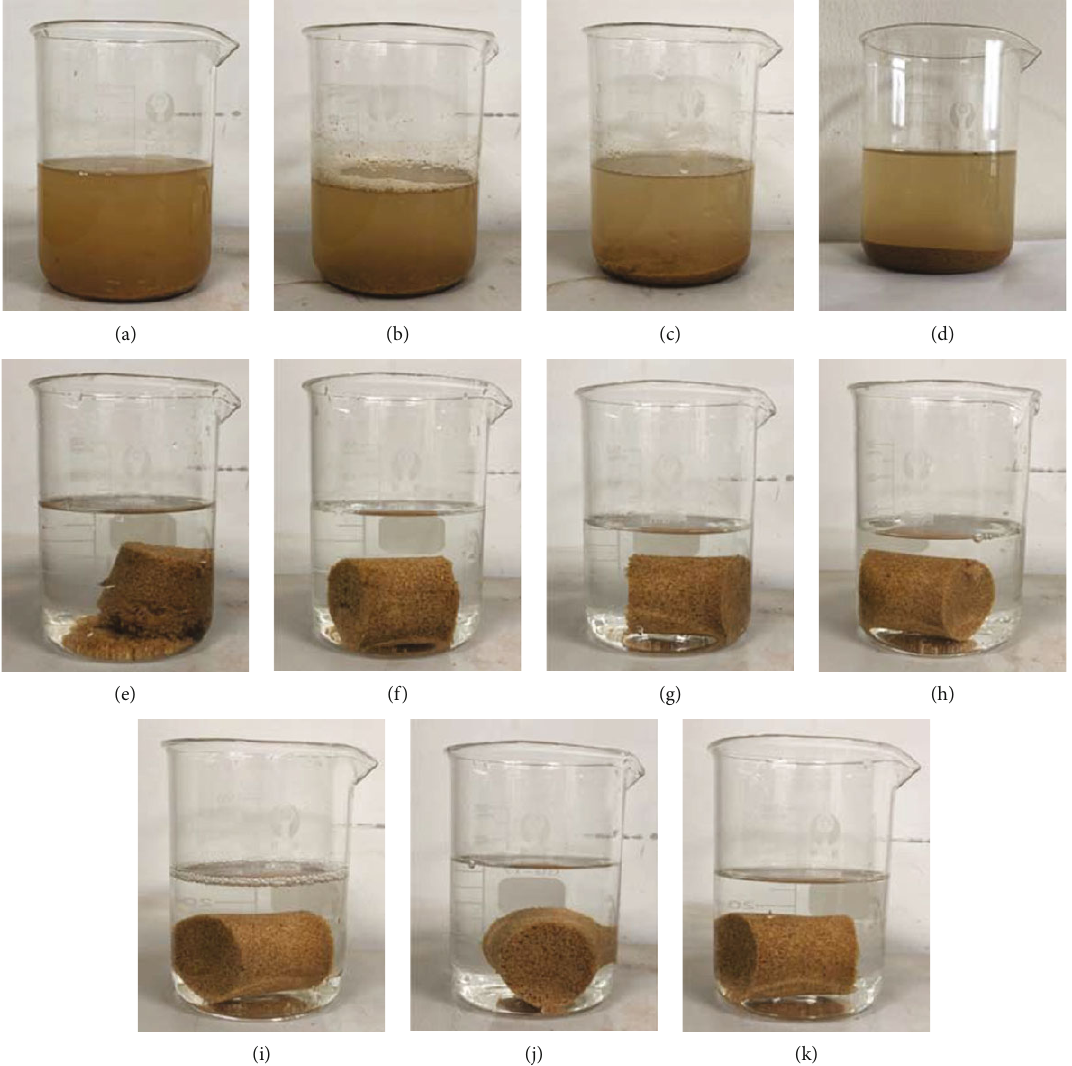
Figure 6: The state of the specimens with di ff erent PU content after oscillating: (a) 0%; (b) 0.1%; (c) 0.2%; (d) 0.3%; (e) 0.4%; (f) 0.5%; (g) 1%; (h) 2%; (i) 3%; (j) 4%; (k)